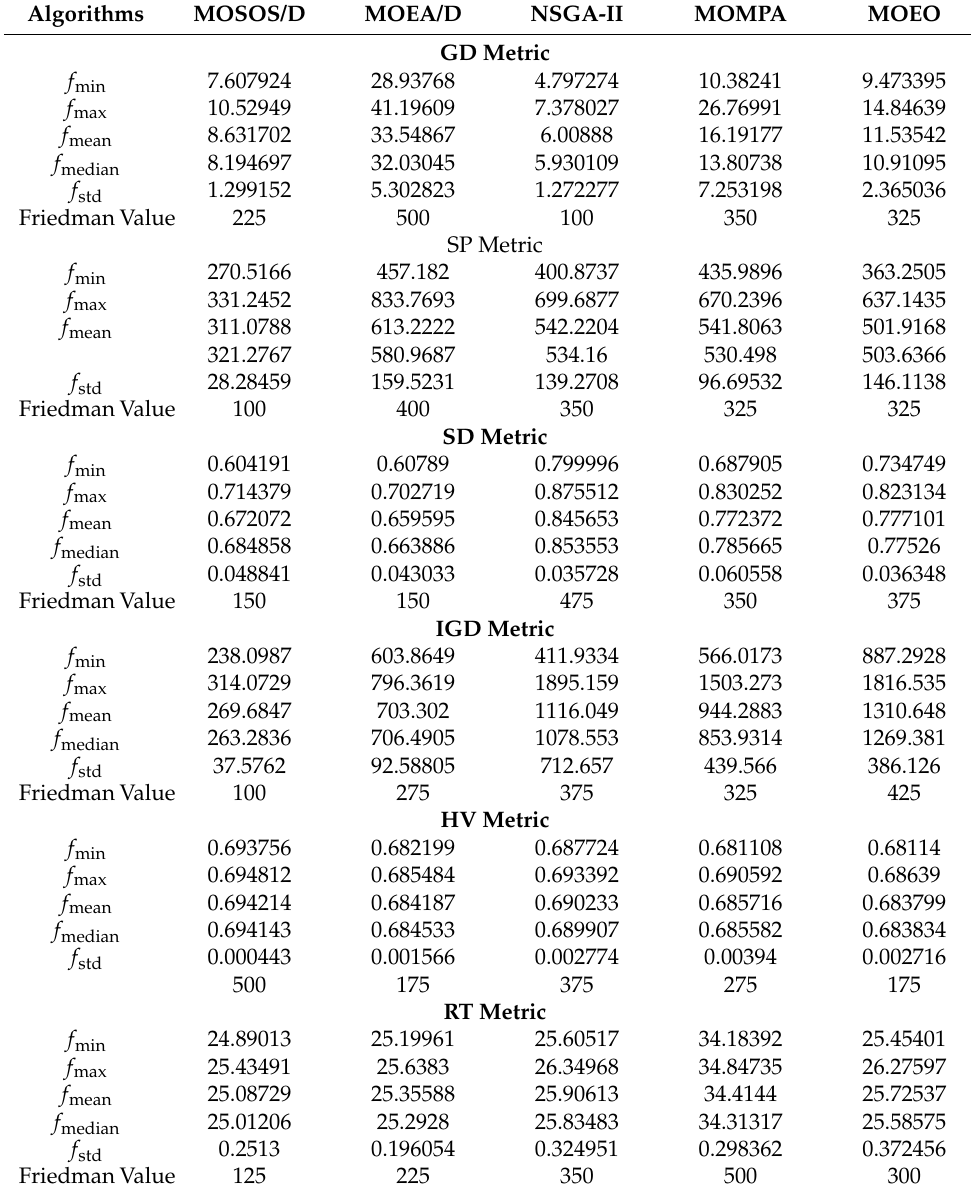
Table 9. The results of different metrices for the 25-bar truss bar